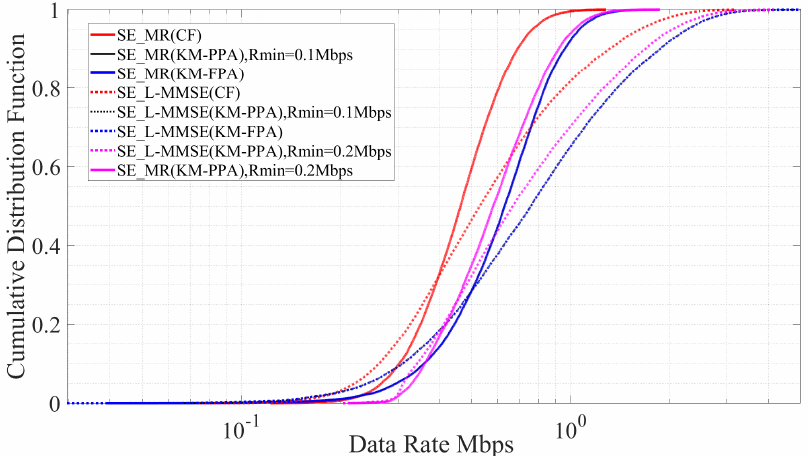
Figure 6. Cumulative distribution function of data rates for